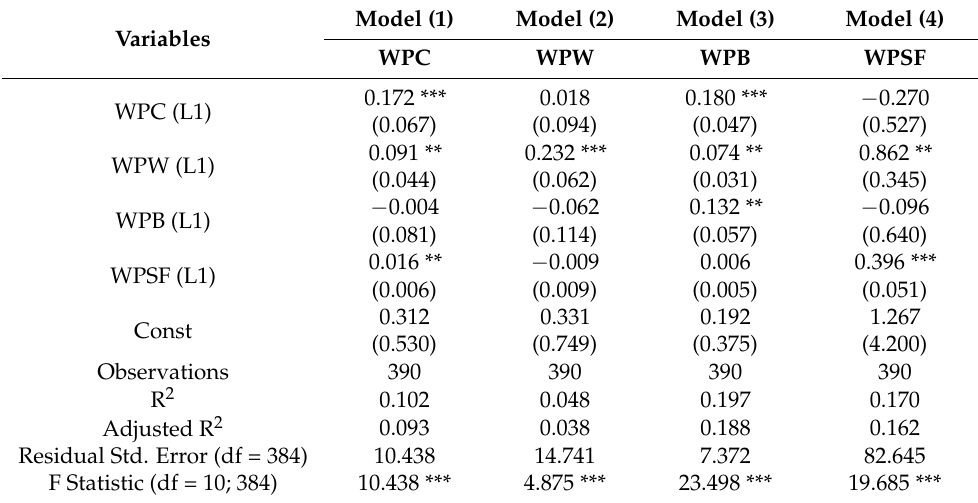
Note: Table 2 indicates the coefficients and standard errors of the VAR (1) model using four variables in the system. The variables hold 390 observations out of 391 due to one autoregressive lag used in the system. The series covers the entire period from 1 January 1990 to 1 July 2022. ***, ** and * denote significance at the 1, 5, and 10 percent levels,